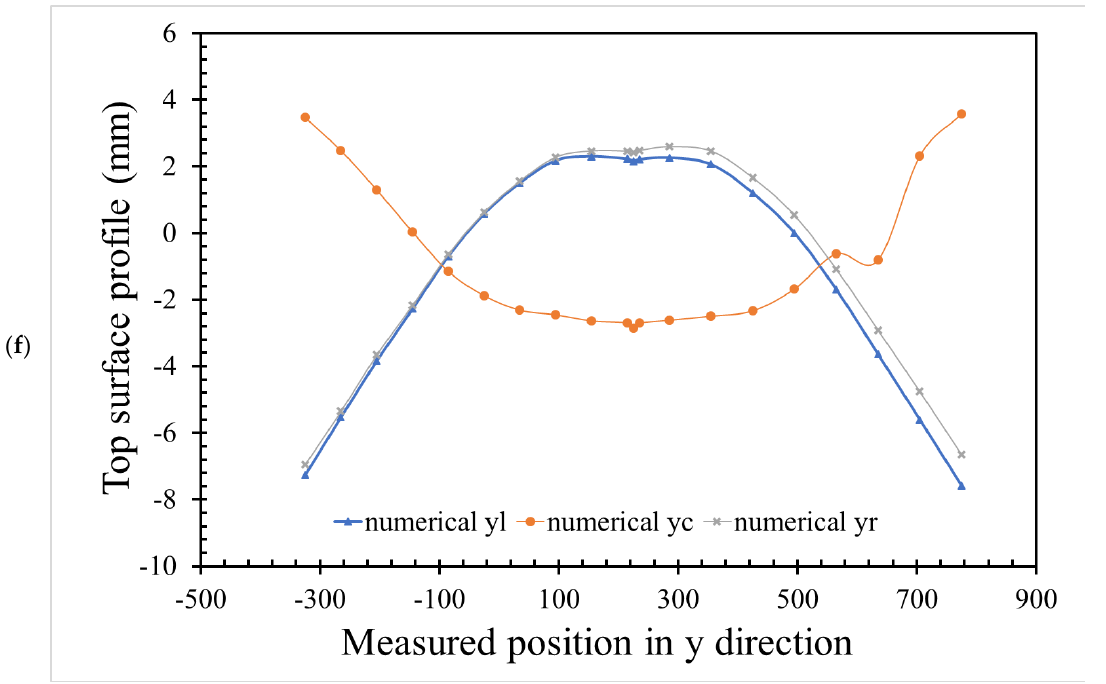
Figure 6. Simulated temperature distributions and warpage in the height direction of a half-pallet: ( a ) temperature distribution at the end of compression; ( b ) temperature distribution at the end of cooling; ( c ) isometric view of the numerical top warpage profile of the half-pallet; ( d ) flatness of the half-pallet top surface; ( e ) x-axial top surface profiles; ( f ) y-axial top surface profiles. The pallet temperature gradually decreased with respect to the cooling time.